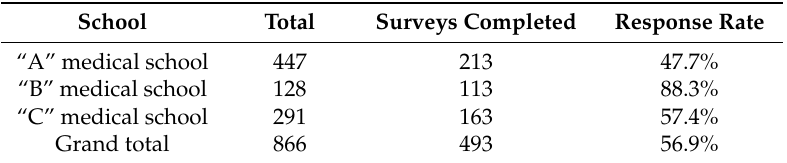
Table 1. Survey response